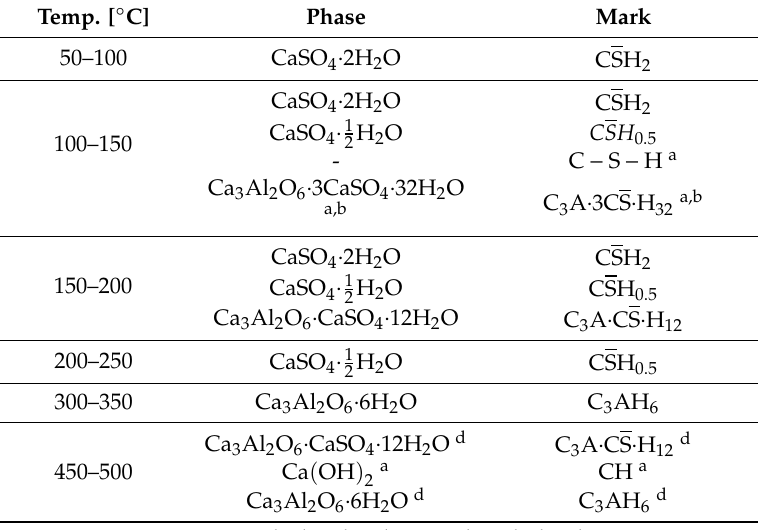
Table 3. Summary of cement phase